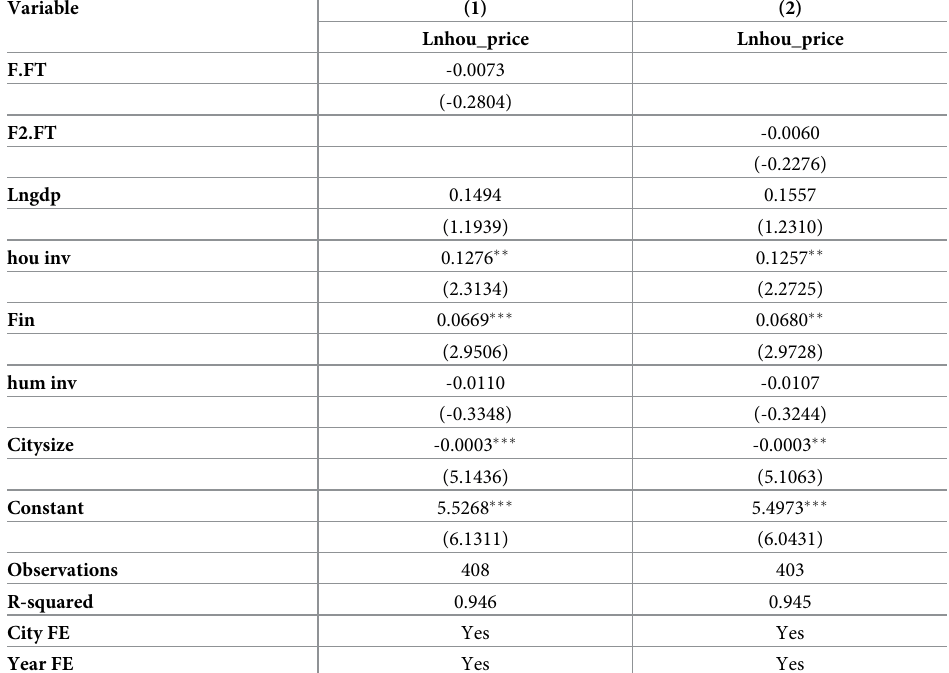
Table 4. Placebo